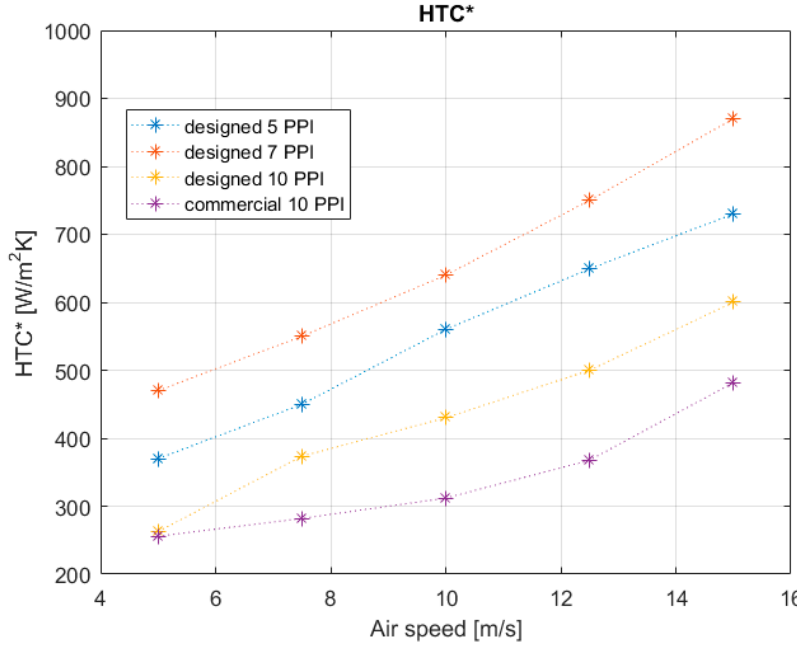
Figure 10. HTC* versus air speed of specific typology and comparison between the different models.